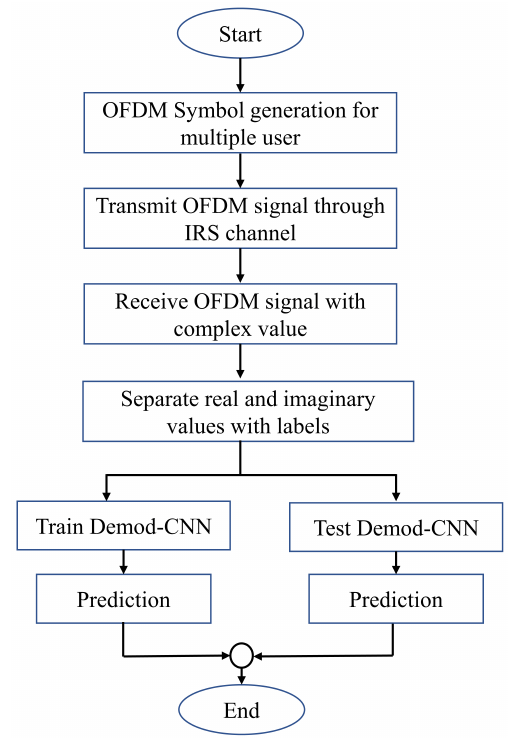
Figure 3. Flowchart for the proposed system